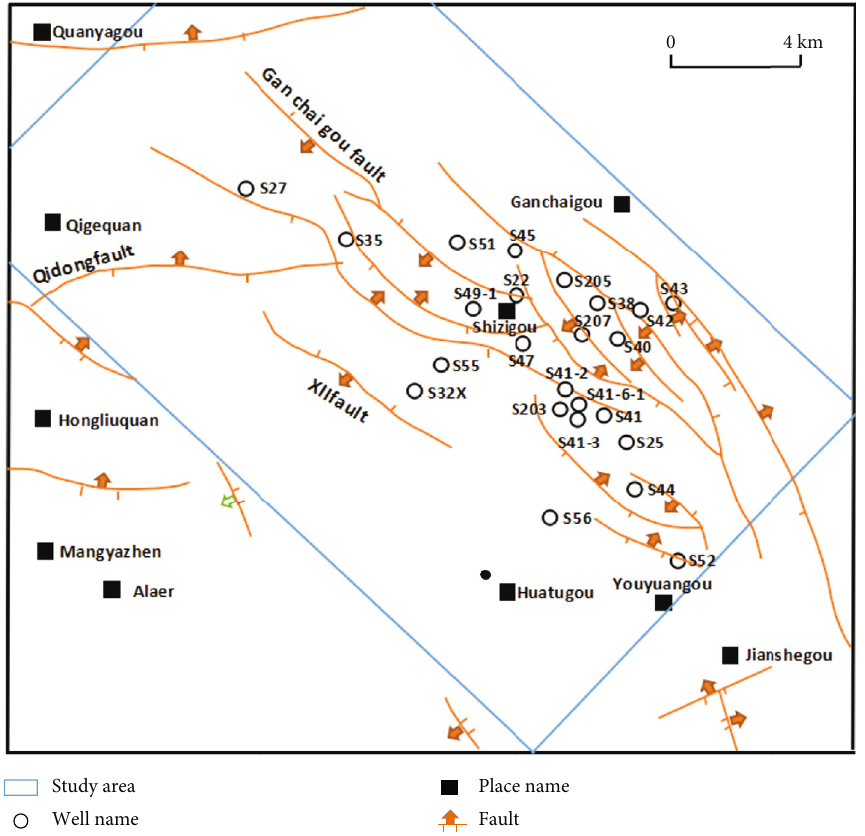
Figure 1: The location of the Yingxi region in the western Qaidam Basin